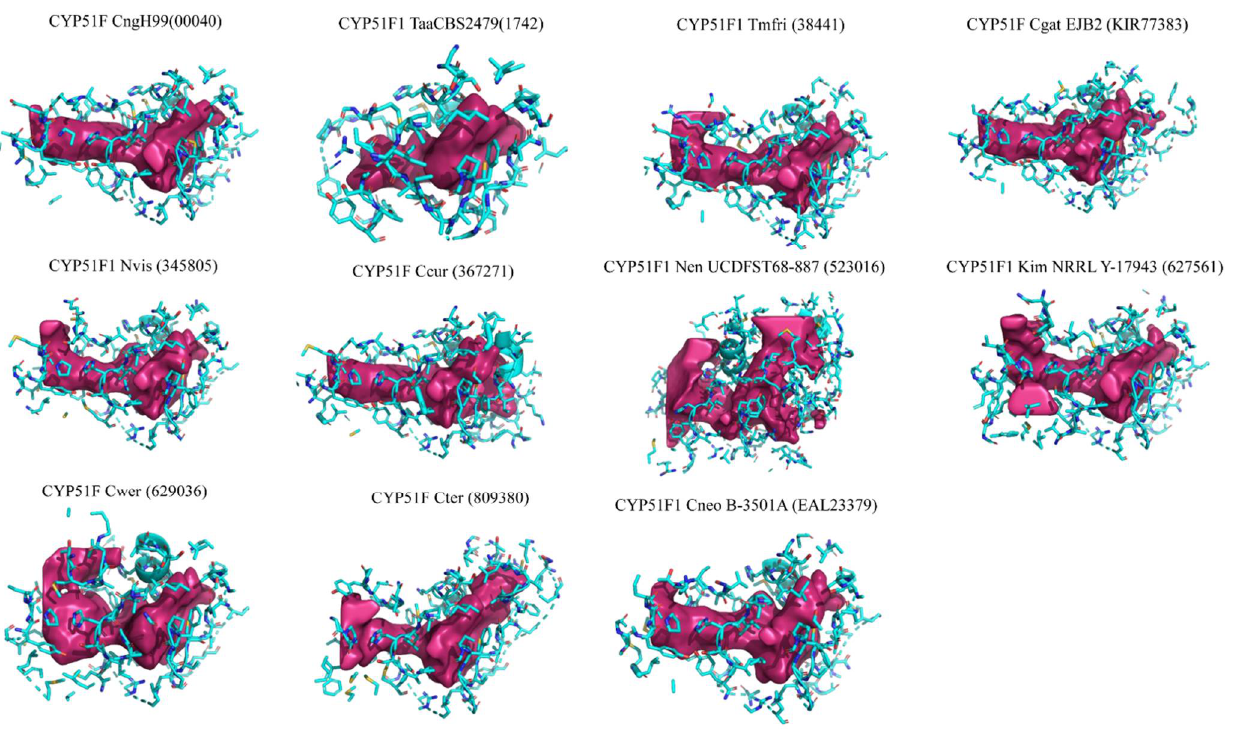
Figure 3. Active site cavities of 11 CYP51s from Tremellomycetes . The active site cavity surface is shown in pink and amino acids, part of the active site cavity, are represented using a ball and stick model. A detailed list of amino acids, part of the active site cavity, is presented in Table S2.